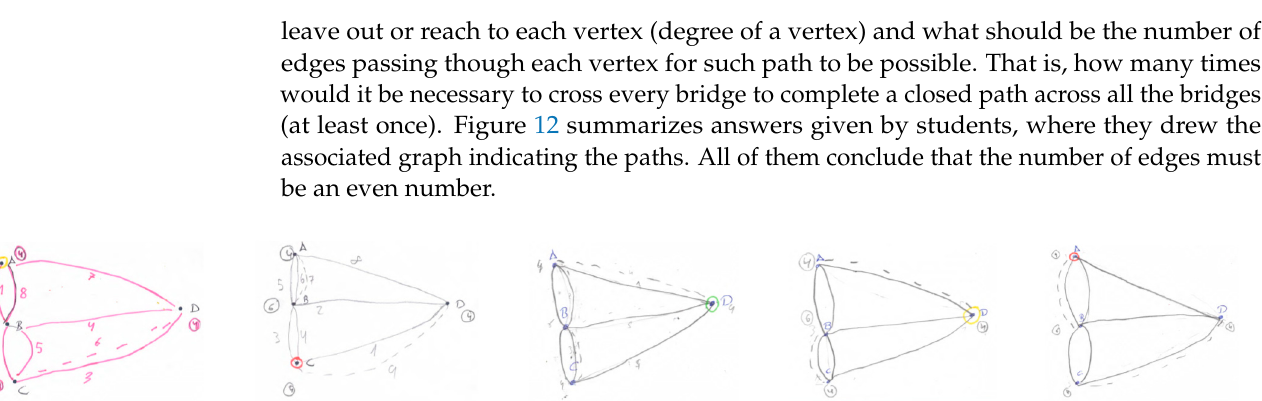
( e ) Figure 11. Köningsberg bridges. Drawing made by participant: ( a ) A7; ( b ) A6; ( c ) A5; ( d ) A3; ( e ) A4. Only participants A7 and A6 set a dot in every region and draw the associated graph